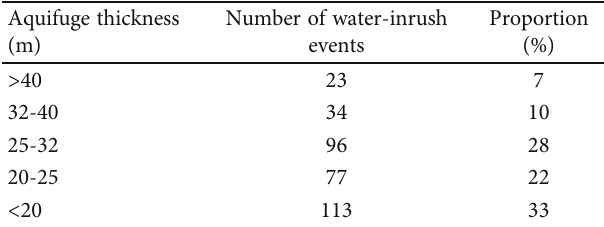
Table 1: Relationship between aquifuge thickness and number of water inrush in typical mining